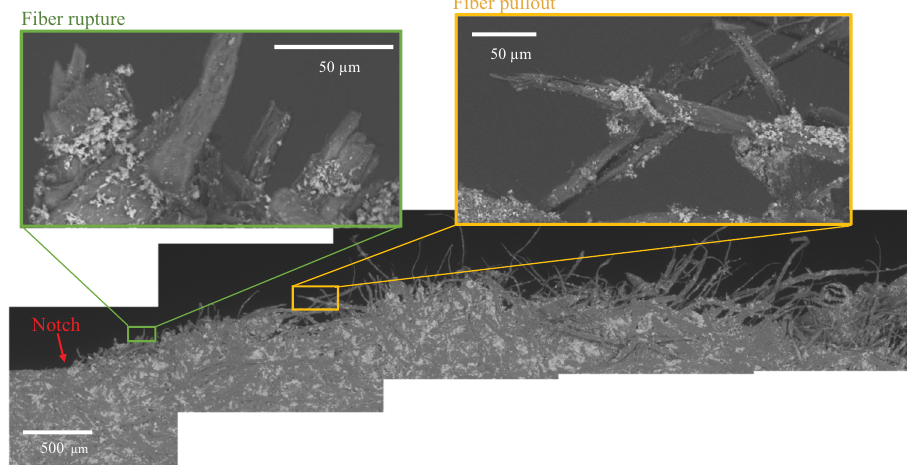
Fig. 4 Intermediate fatigue life crack pro fi les. Scanning electron microscopy images of a representative, intermediate fatigue life ( N f = 18501 cycles) showed the distinctive fi ber rupture and pull-out